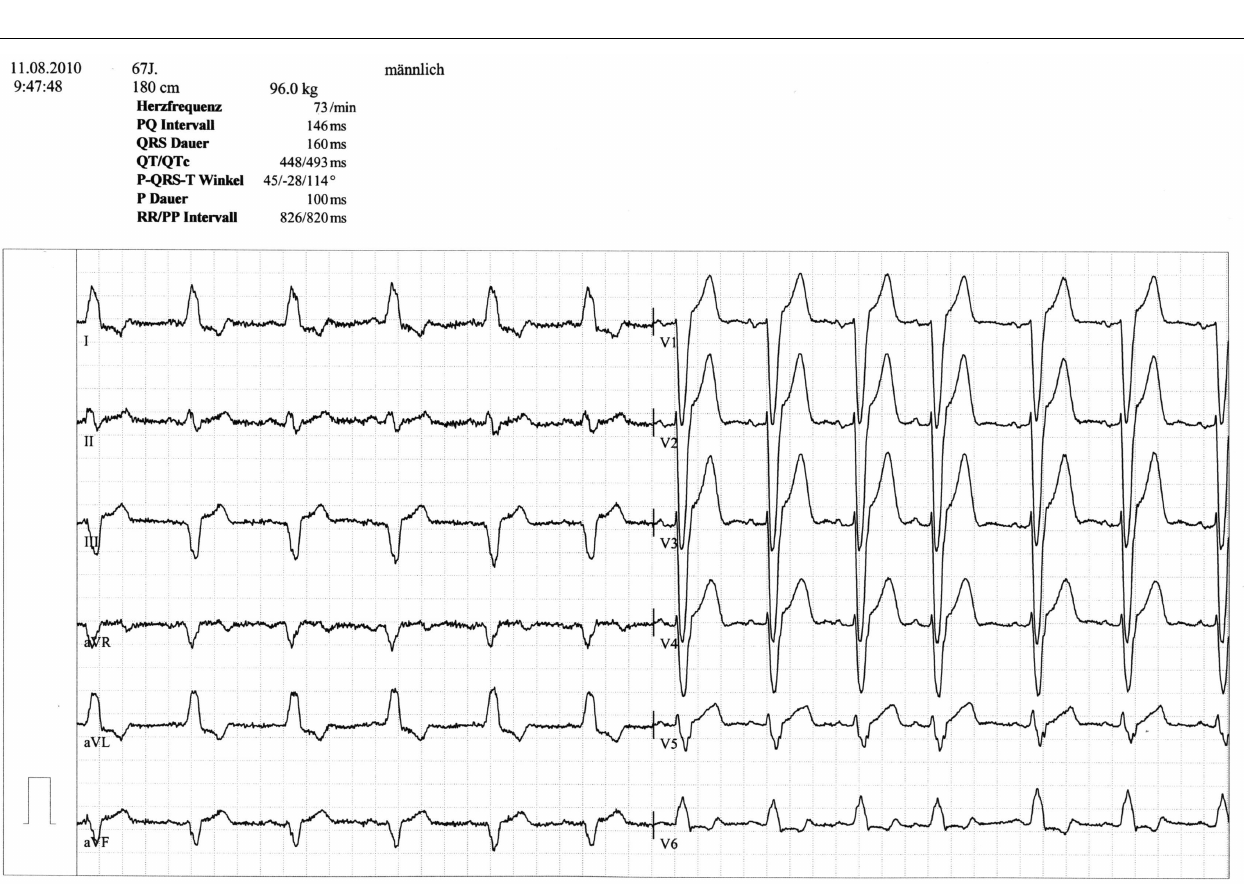
FIGURE 2 | ECG displaying LBBB at week 8 visit (patient